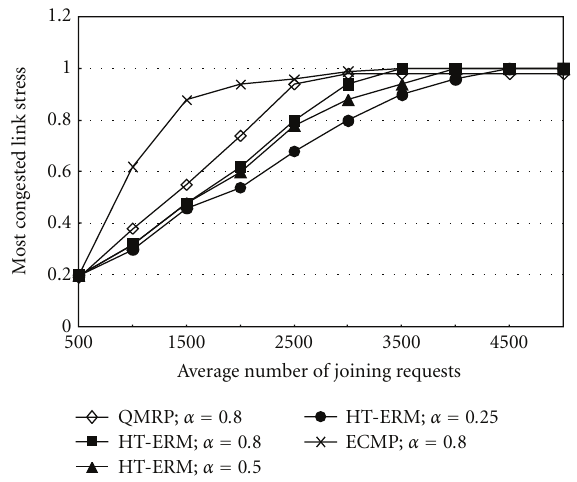
Figure 7: Multicast tree link resource usage versus group joining requests.